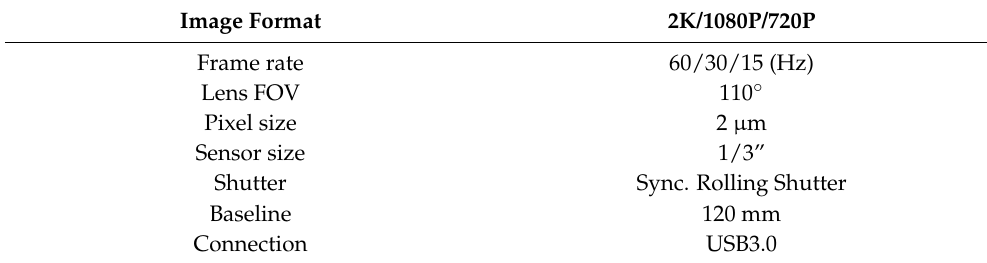
Table 1. ZED technical specifications.